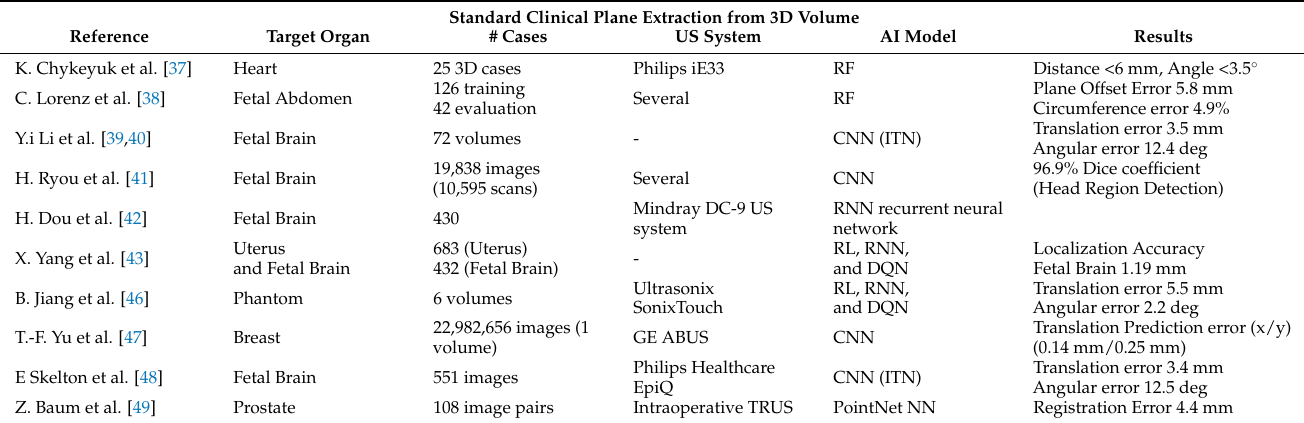
Table 2. Summary of publications on standard clinical plane extraction from